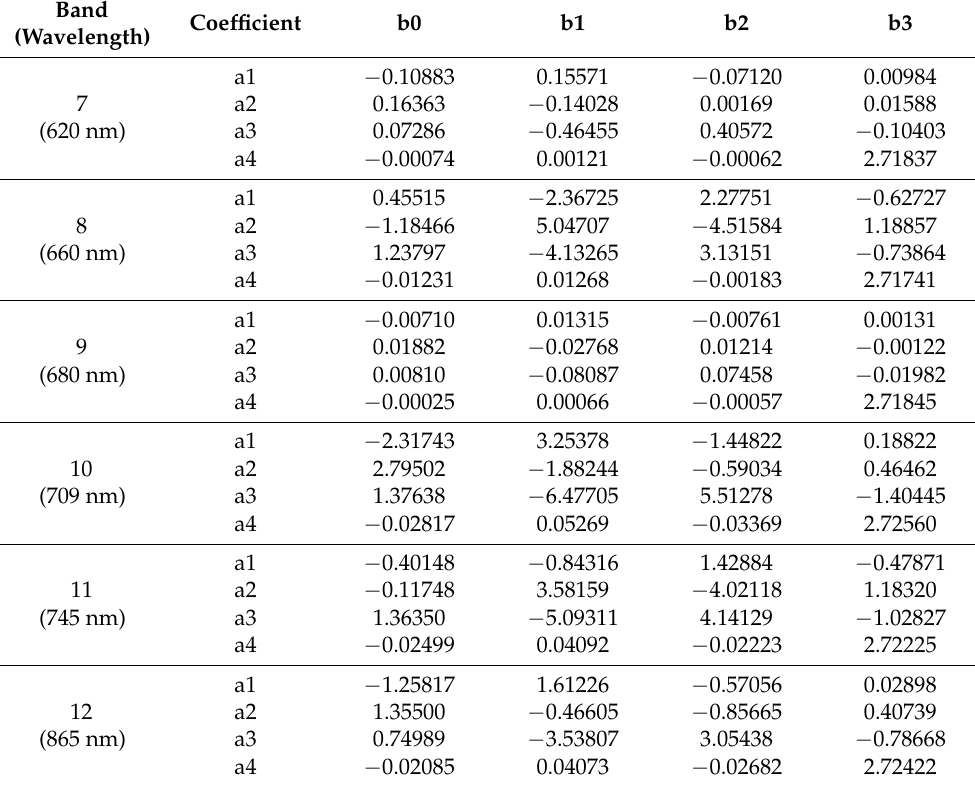
Table 1. Regression coefficients for the estimation of water vapor transmittance